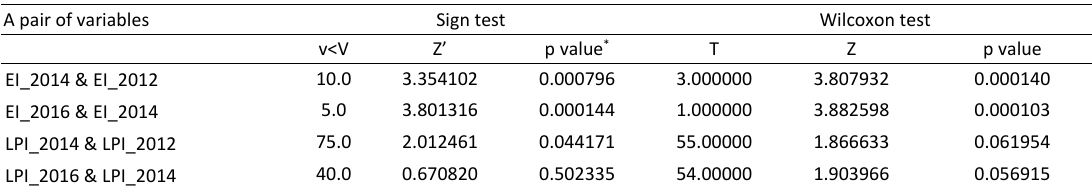
Table 4: Sign test and Wilcoxon test for development measures of entrepreneurship rate and logistics performance